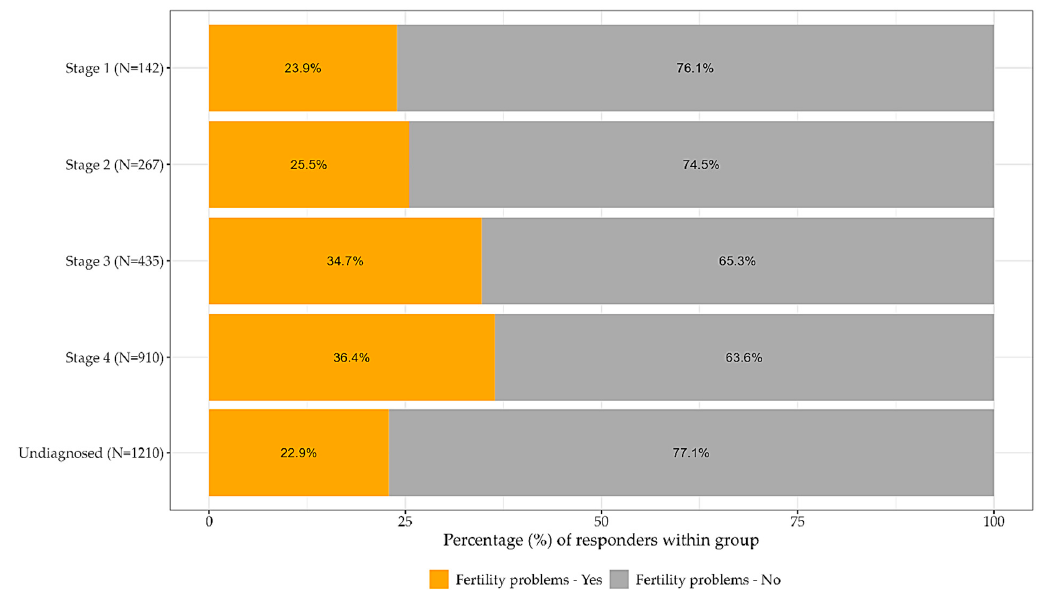
Figure 4. Fertility abnormalities in relation to stage. The figure shows the percentage of participants who experience fertility abnormalities in relation to their reported stages. The percentages of respondents are shaded according to their answer.